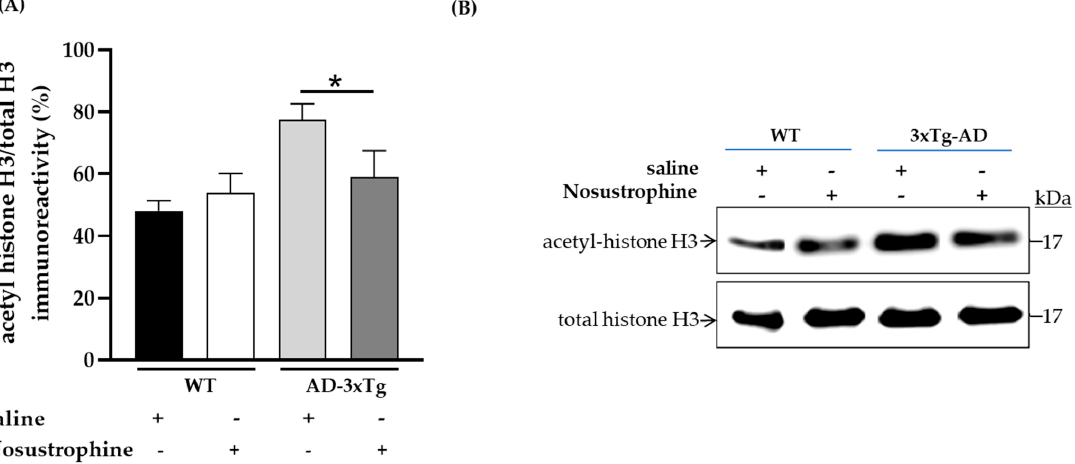
Figure 10. Nosustrophine promotes deacetylation of histone H3, a SIRT1 substrate, in older 3xTg- AD mice. Integrated optical densities for acetylated-histone H3 and total histone H3 levels were assessed by immunoblotting in the hippocampus in WT, and older (8–9-month-old) 3xTg-AD mice ( n = 2–3 animals per group) ( A , B ). Data are expressed as means ± S.E.M. across treatment groups. One-way ANOVA followed by Tukey’s post hoc comparisons, * p < 0.05. WT, wild-type; 3xTg-AD,